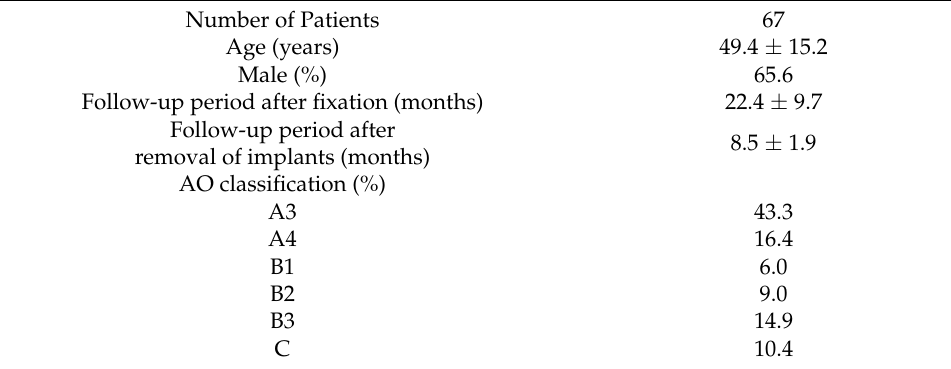
Table 1. Characteristics of the patients who underwent thoracolumbar